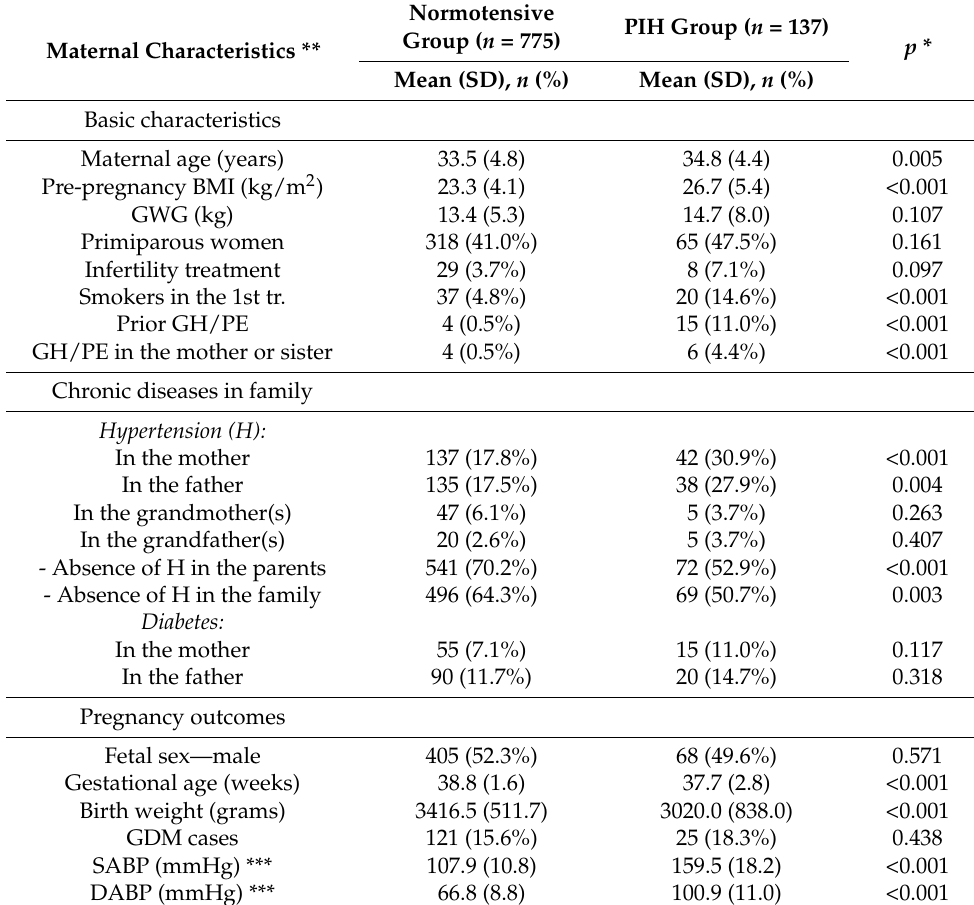
Table 2. Basic characteristics of the women who developed pregnancy-induced hypertension (PIH).